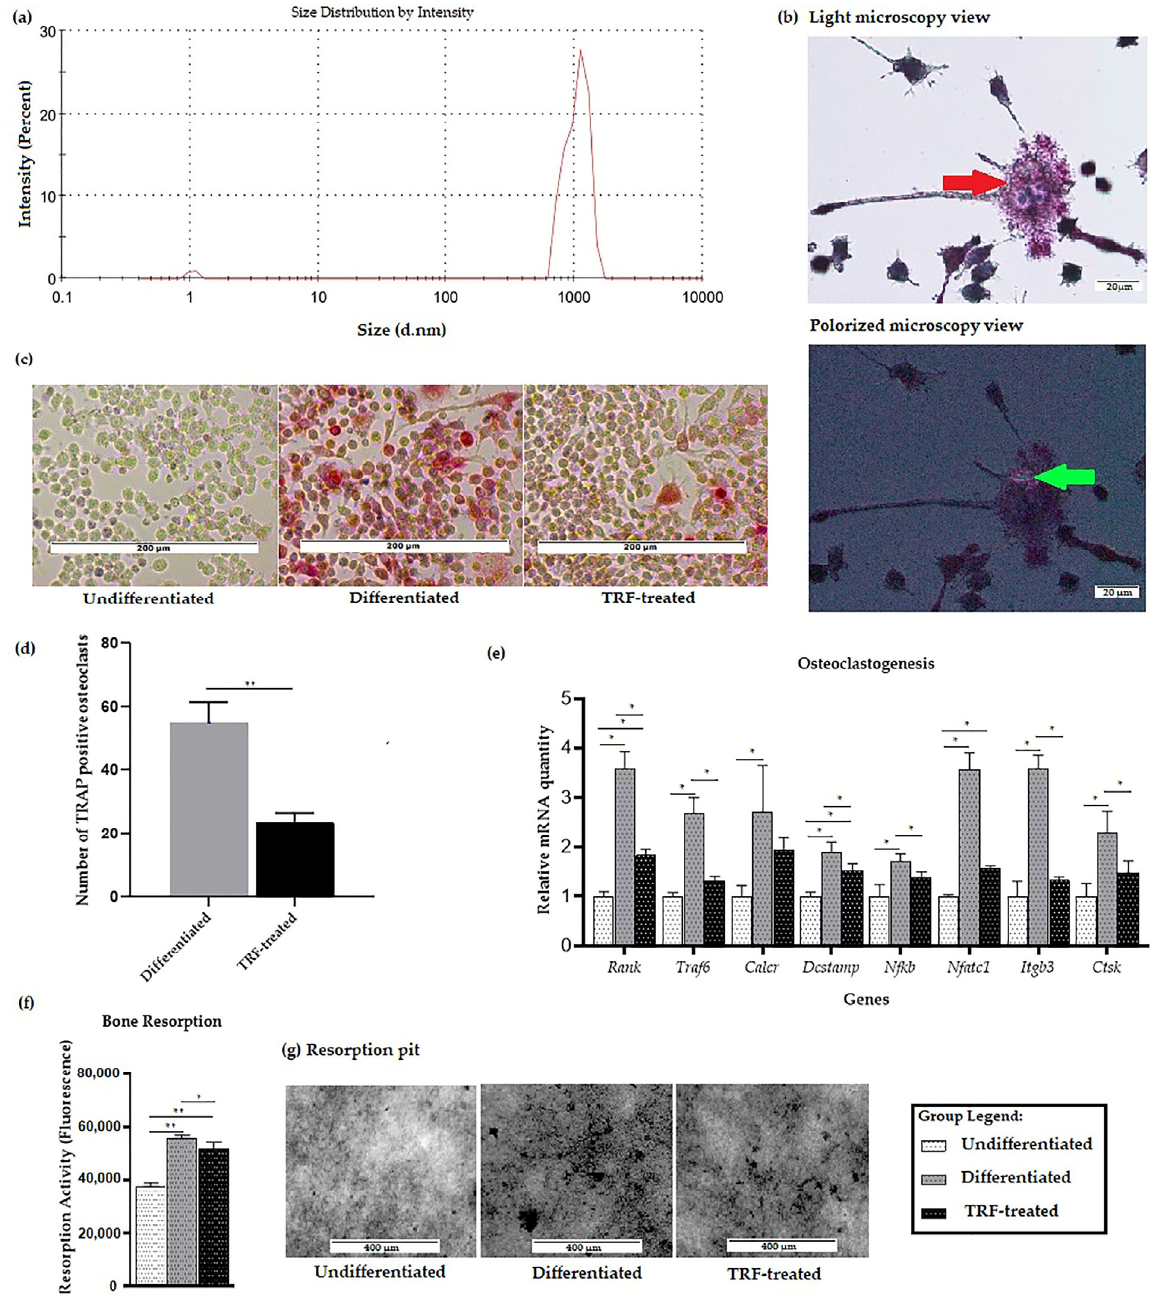
Figure 1. Validation of PE-induced osteoclastogenesis in vitro: ( a ) Distribution of particle size of PE particles. ( b ) Micrograph showing multinucleated cells (red arrow) formed after exposure to PE particles following RANKL induction. PE particles (bi-refringence under the polarized view, green arrows) were seen in close proximity to macrophages/osteoclasts stained with hematoxylin and TRAP (200× magnification). ( c ) Micrograph showing TRAP staining of three different groups (100× magnification). ( d ) TRAP-positive osteoclasts were counted over a 208 mm 2 area using 100× magnification. Average of five areas per well for differentiated group and TRF-treated group were subjected to t -test analysis ( e ) Expression profiles of osteoclast-related genes. Data are presented as relative mRNA quantity ± SD, normalized to the undifferentiated group. ( f ) The resorption activity of three different groups was measured as fluorescence activity. ( g ) Resorption pit formation (represented from the black dots) in three different groups. ANOVA followed by Tukey’s post-hoc analysis was performed for data in ( d – f ). * indicates p < 0.05 and ** indicates p <